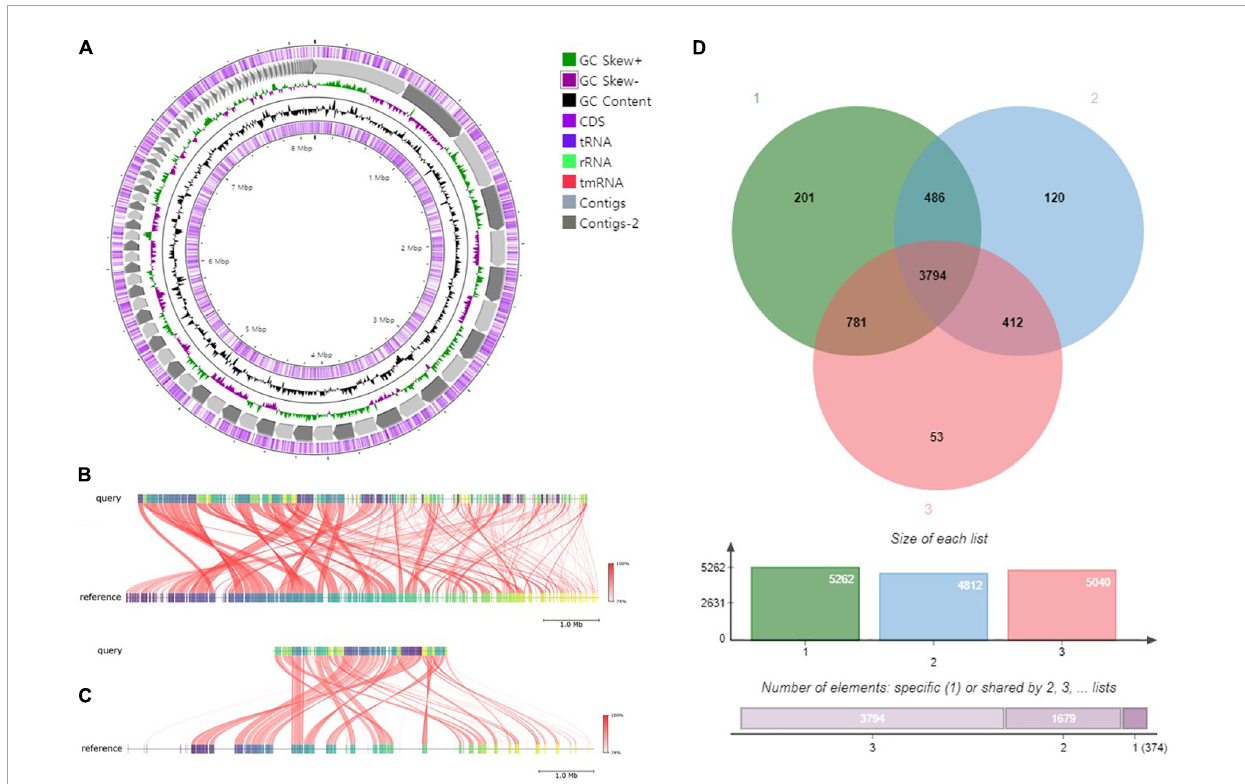
FIGURE10 Graphical genome map of strain RG36 T . RNA genes (tRNAs dark blue, rRNAs light green, and tmRNA red), GC content, and GC skew (A) . Illustration of FastANI’s work-flow for computing ANI between a query genome (strain RG36 T ) and a reference genome ( P. acidiphila 7Q-K02 T ) (B) and P. sacchari IPT101 T (C) . Each red line segment denotes a reciprocal mapping between the query and reference genome, indicating their evolutionary conserved regions. Venn diagram of whole-genome orthologous genes in RG36 T and two reference strains. The numbers in the diagram indicate overlapped conserved genes or non-overlapped unique genes in each species. Strain: 1, RG36 T ; 2, P. acidiphila 7Q-K02 T ; 2, P. sacchari IPT101 T (D)